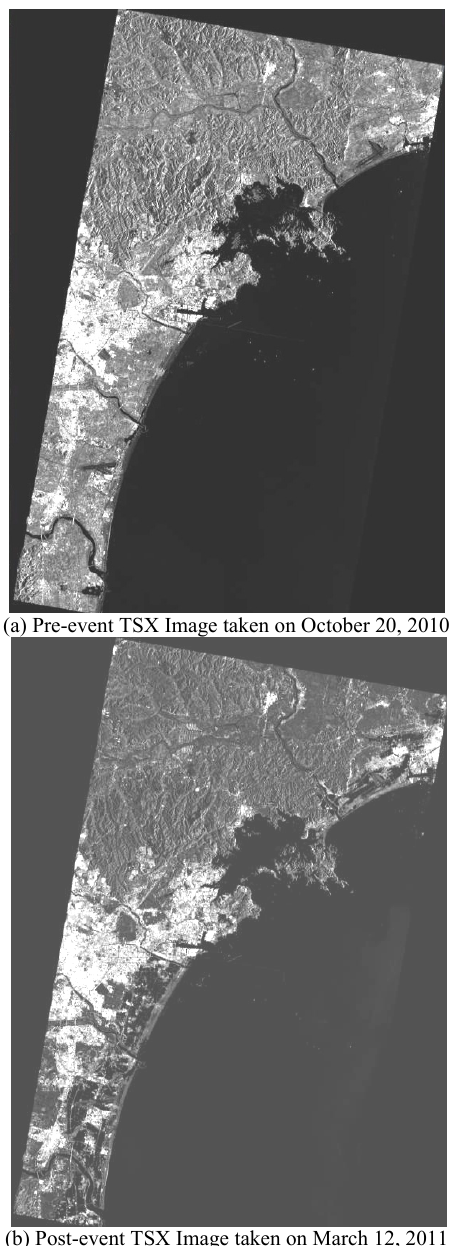
(b) Post-event TSX Image taken on March 12, 2011 Figure 2. Pre- and post-event TSX images acquired respectively on October 20, 2010 (a) and March 12, 2011 (b). These two TSX images have been accurately co-registered and radiometrically